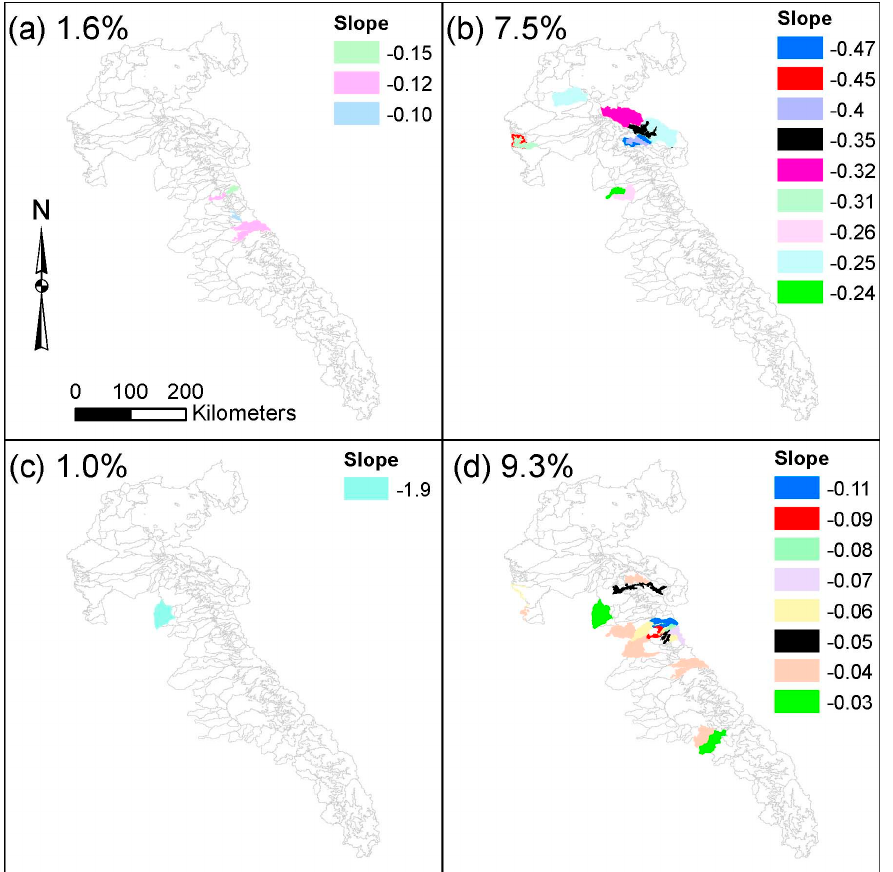
Figure 8. Study basins with significant (at a significance level of 0.05) trend in precipitation indices ( a ) R6h, ( b ) R1D, ( c ) R99, and ( d ) SDII. Other precipitation indices show no significant trend in any study basins. Different colors indicate different trend slopes (in mm/year). Percentages show how much the aggregated area of those basins (with significant trend) accounts for the entire study area.